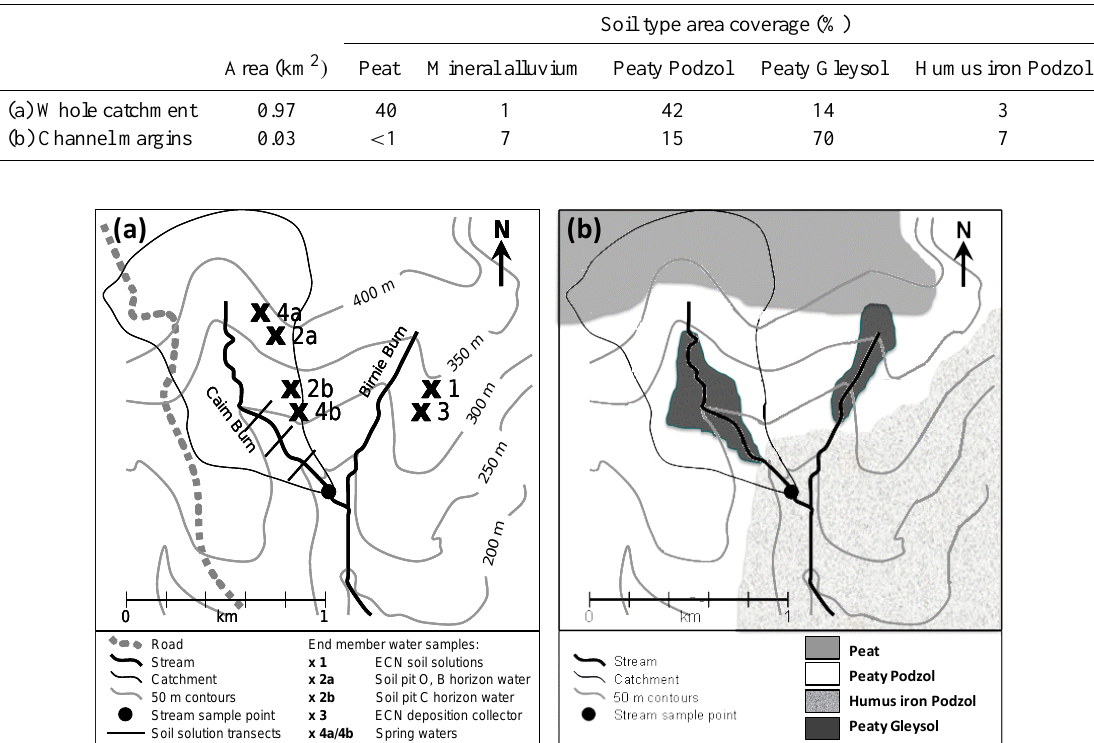
occupy steeper slopes covered by C. vulgaris and V. Figure 1. (a) Catchment location, drainage network, stream and source water sample locations and (b) soil distribution. 7